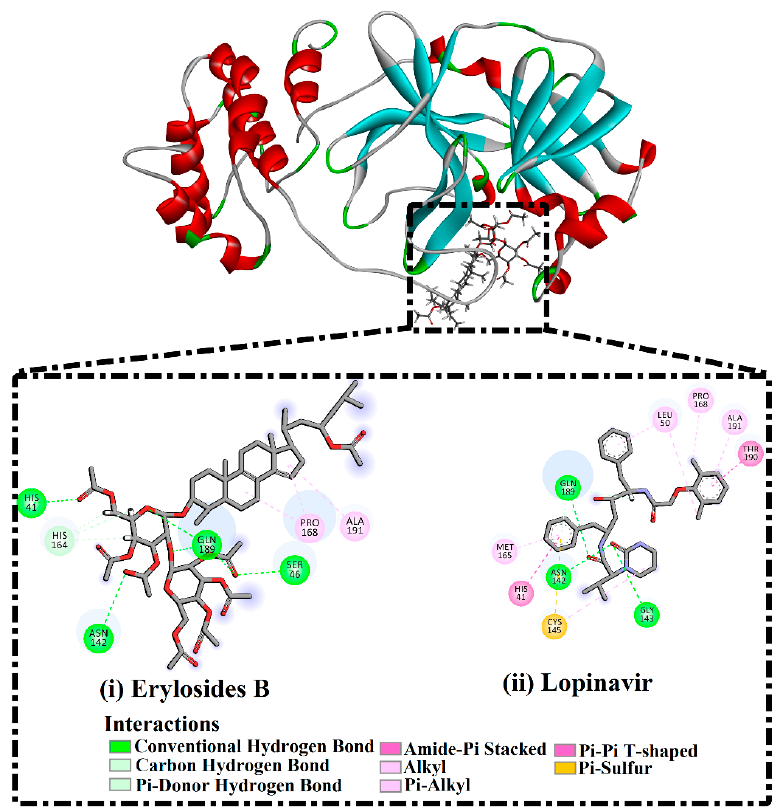
Figure 3. 2D representations of binding modes of ( i ) erylosides B (226)- and ( ii ) lopinavir-M pro complexes according to an average structure over a 100 ns MD simulation.